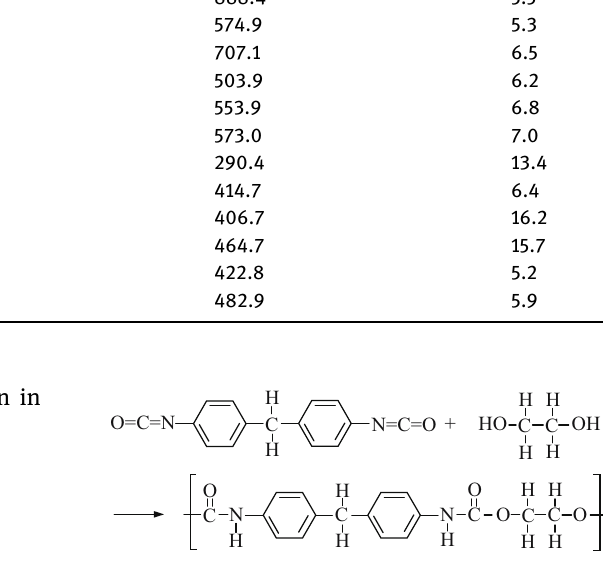
Figure 3: PU molecular synthesis process.